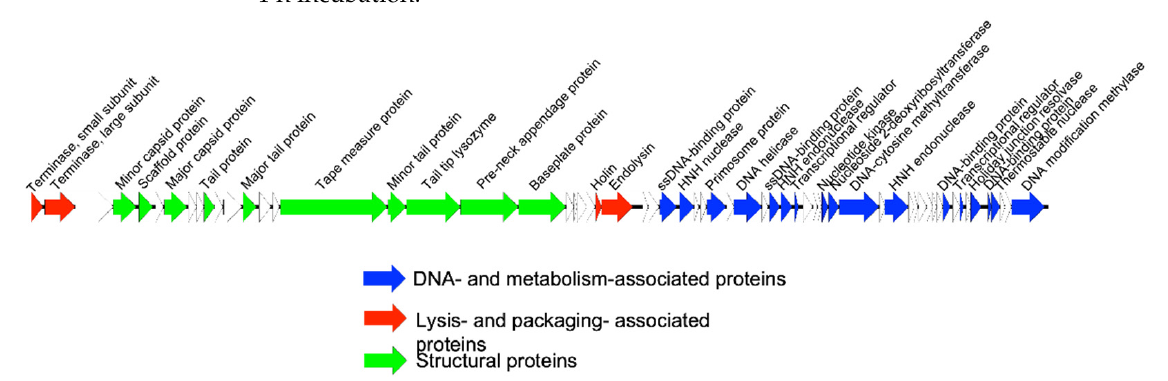
Figure 3. CUB-EPI_14 genome map. Each arrow represents a coding sequence. In red, genes encoding packaging and lysis-associated proteins are displayed; in green, structural proteins; and in blue, DNA- and metabolism-associated proteins (adapted from EasyFig).